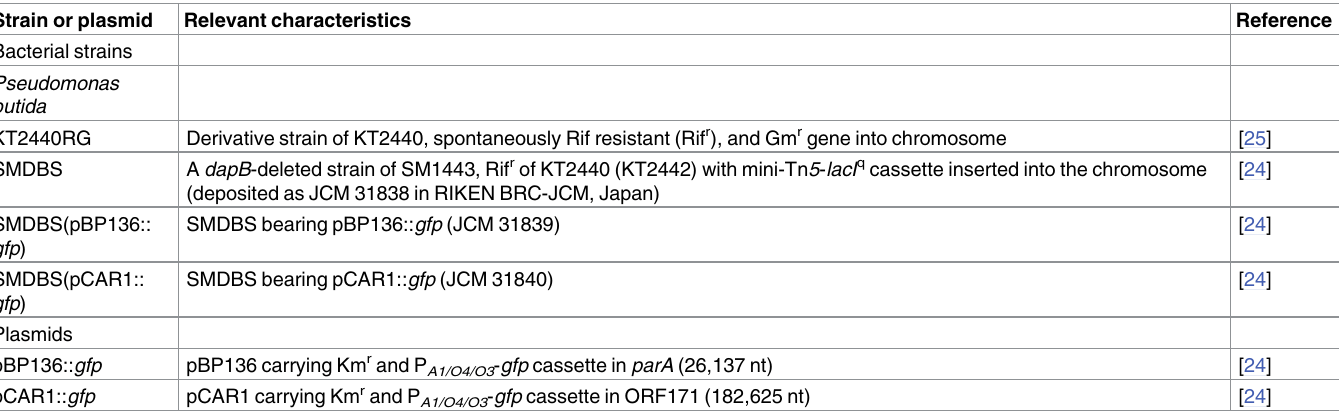
Table 1. Bacterial strains and plasmids used in this study. Strain or plasmid Relevant characteristics Bacterial strains Pseudomonas